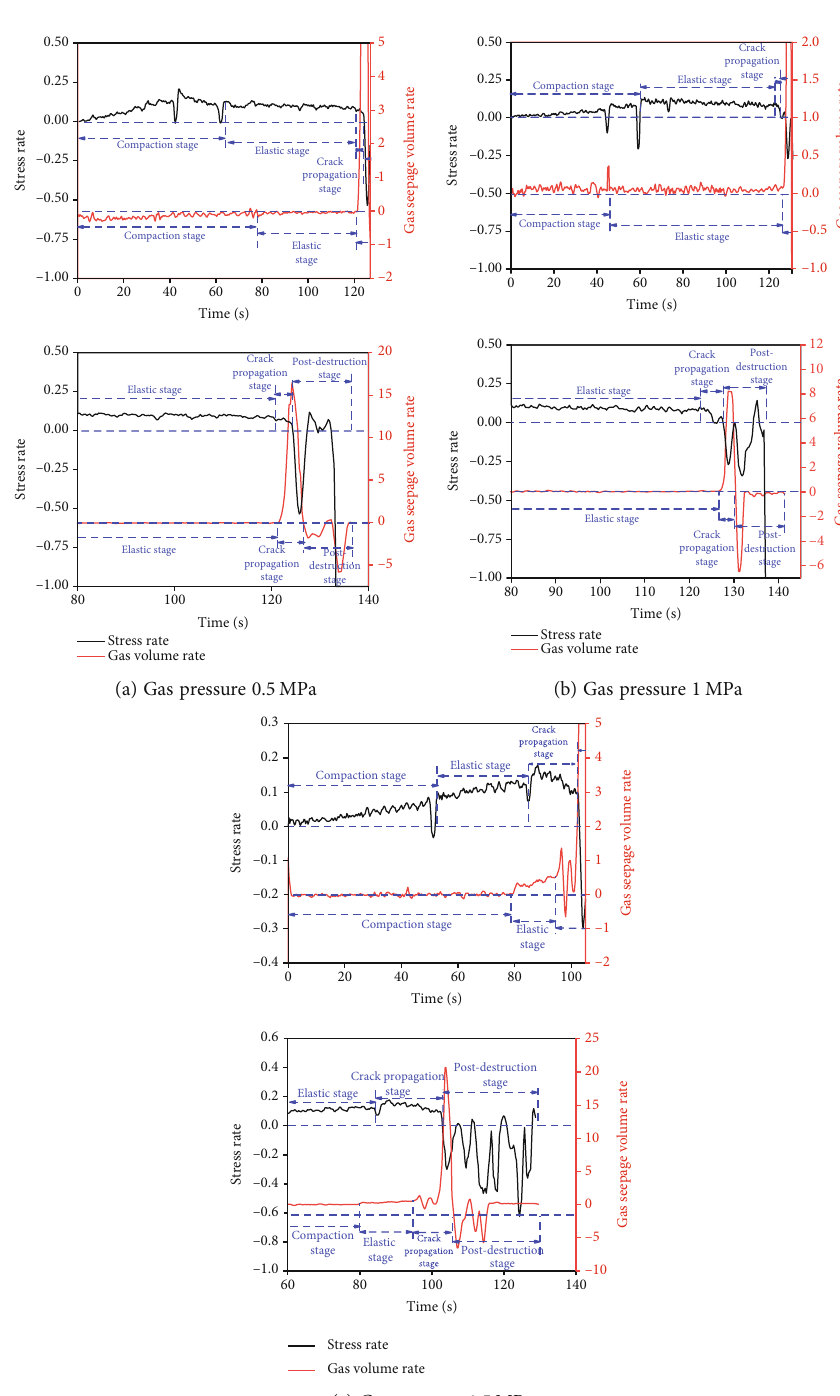
Figure 7: Rate curves of stress and gas seepage volume under di ff erent gas